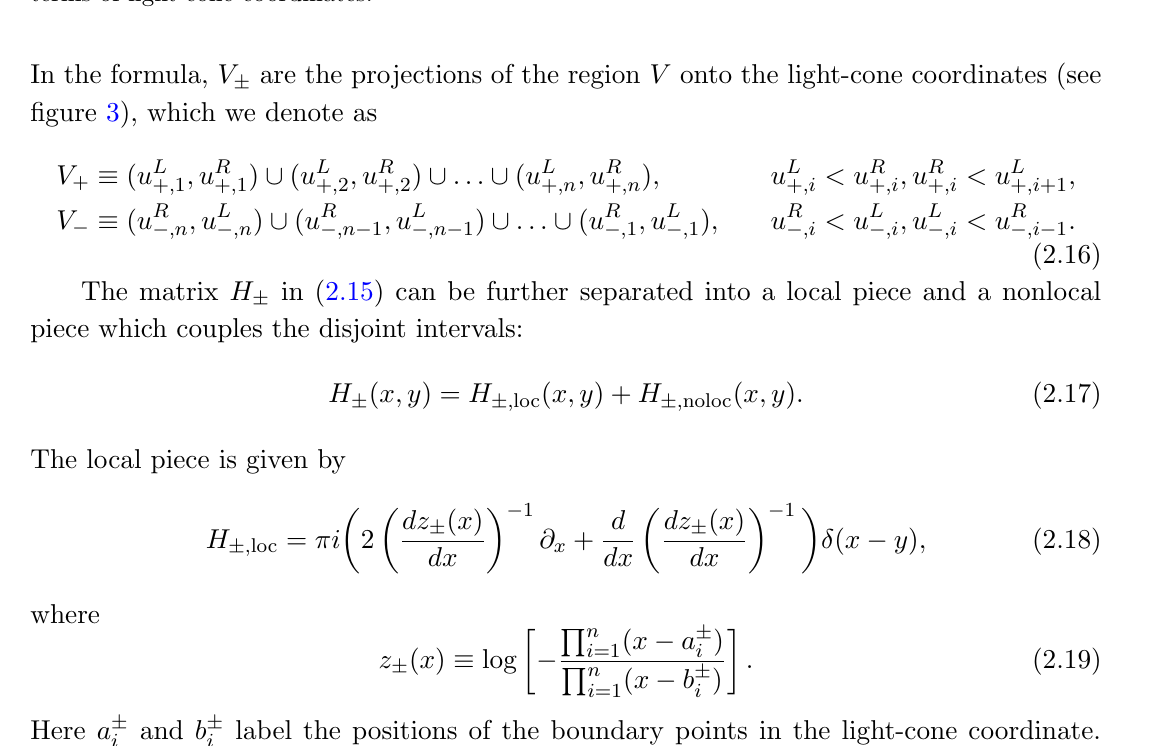
Figure 3 . In the discussion of free chiral fermions, it is convenient to think about the intervals in terms of light-cone